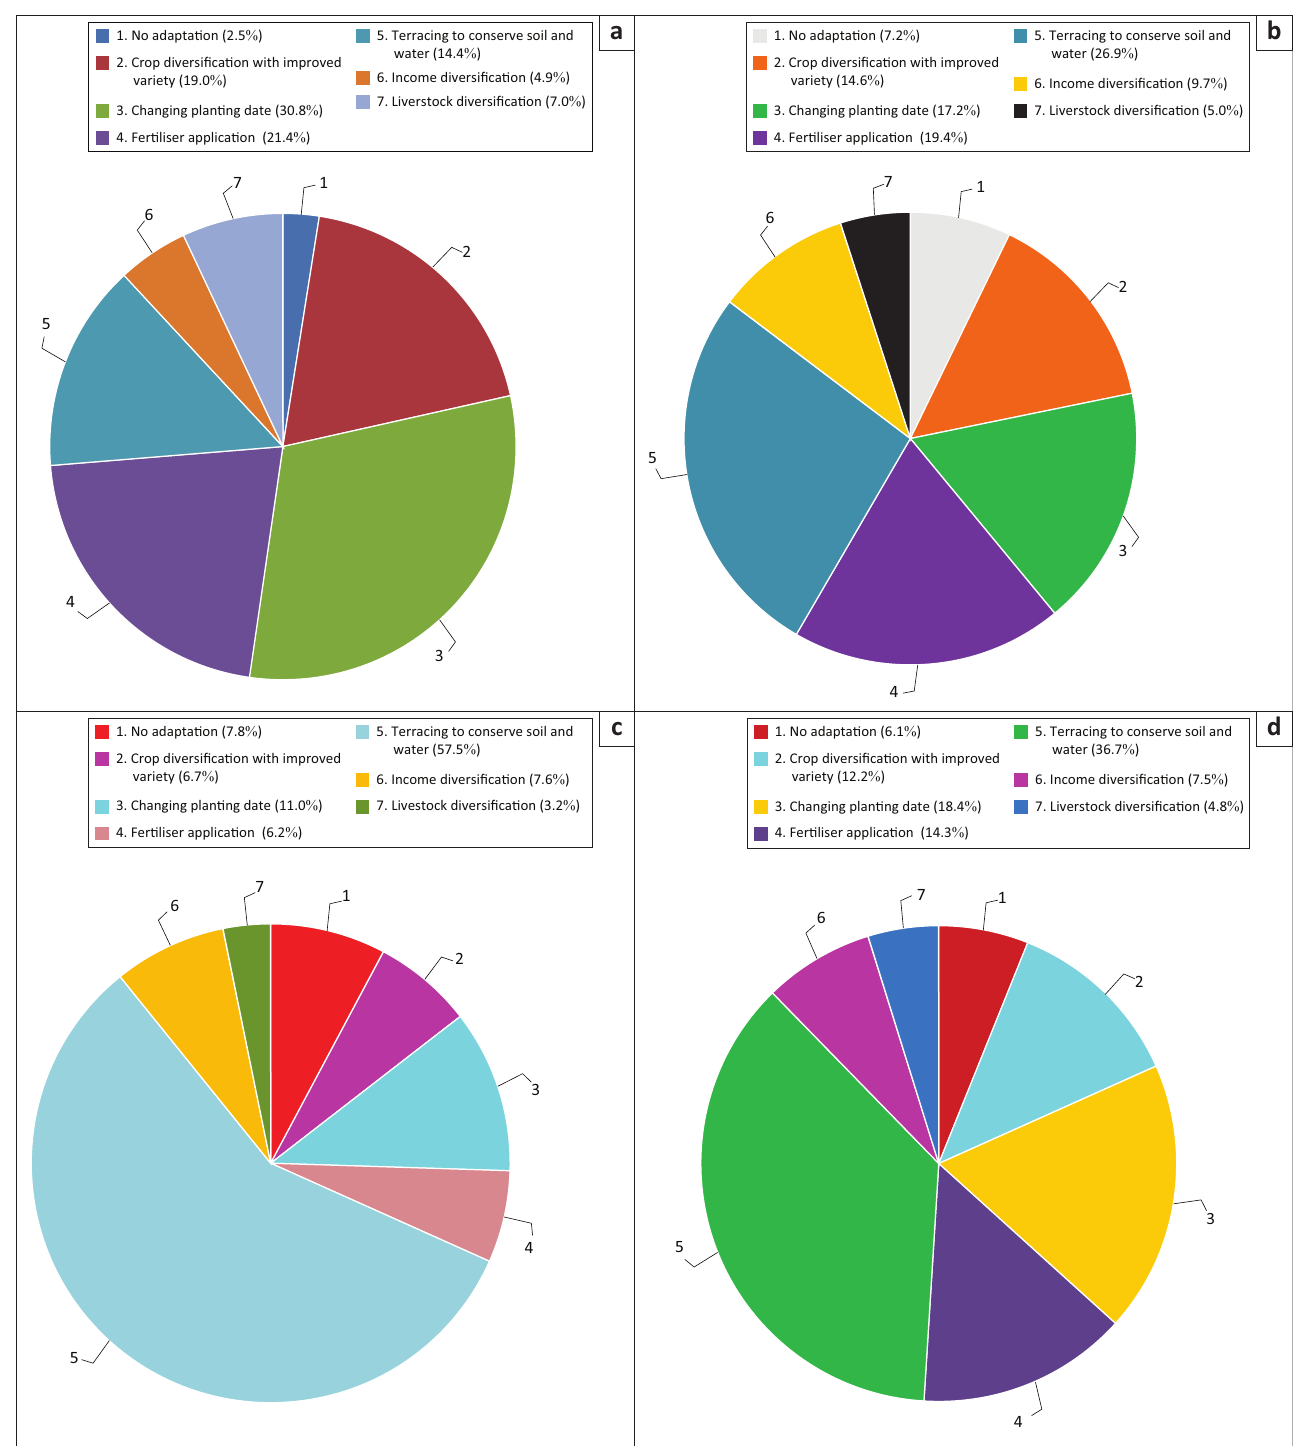
FIGURE 2 : Adaptation strategies used by farmers in each agroecological zones and in the study area. (a) Lowland, (b) Midland, (c) Highlands and (d) in the